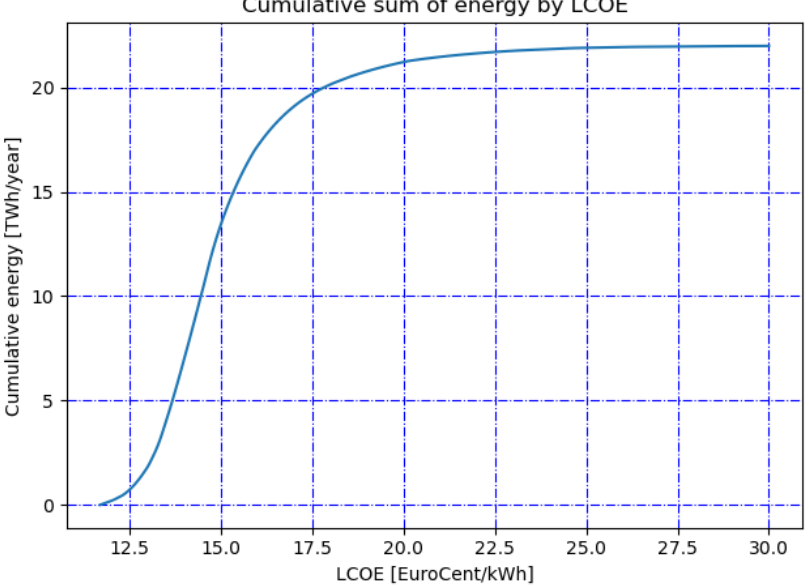
Figure 13. Cumulative sum of energy for all the rooftop surfaces in Sardinia as a function of the levelized cost of